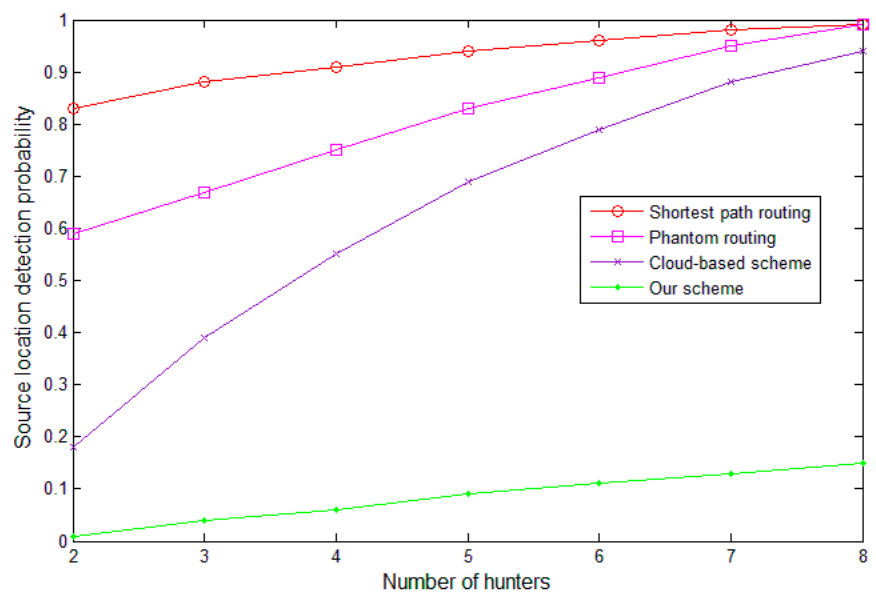
Figure 8. The probability of successfully locating the source node.